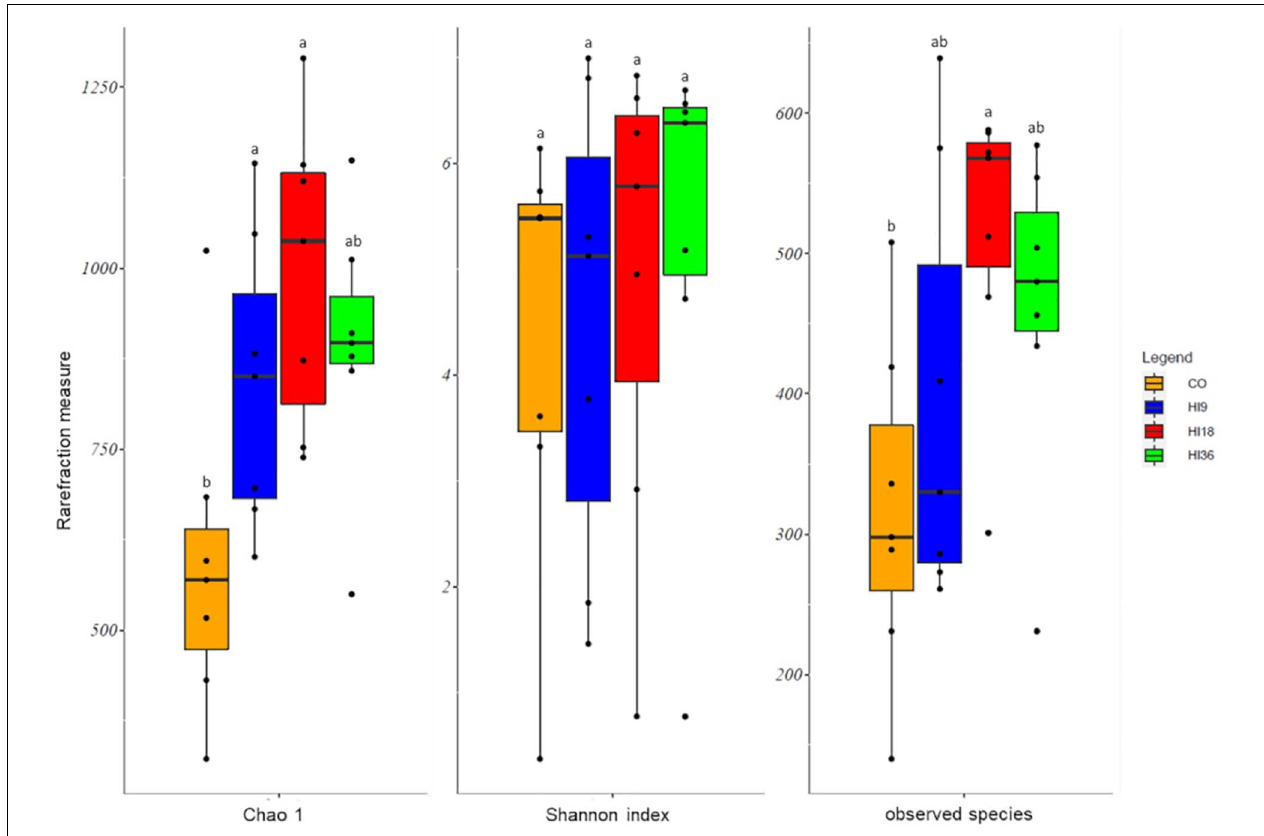
FIGURE 3 | Boxplots showing the alpha diversity rarefaction index across experimental diets. The boxes represent the interquartile range (IR) between the first and third quartiles, and the line inside the boxes represents the median. Whiskers denote the lowest and the highest values within 1.56 IR from the first and third quartiles, respectively. Circles represent outliers beyond the whiskers. Different superscripts within boxplot indicate significant